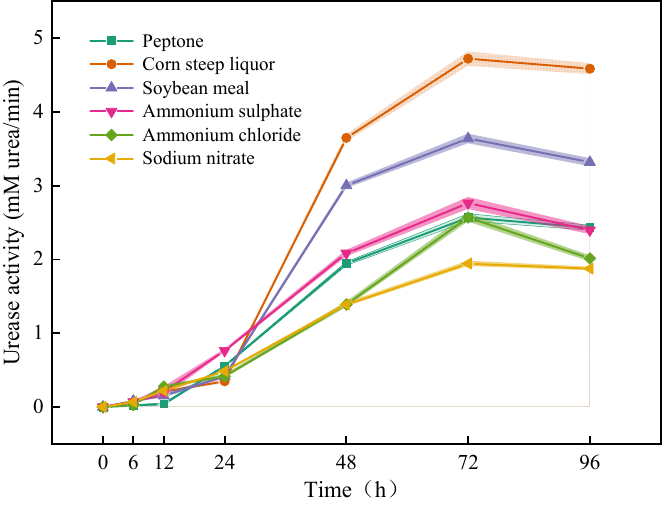
Figure 4. Effects of different nitrogen sources on the urease activity of samples (shadows represent the range of error).